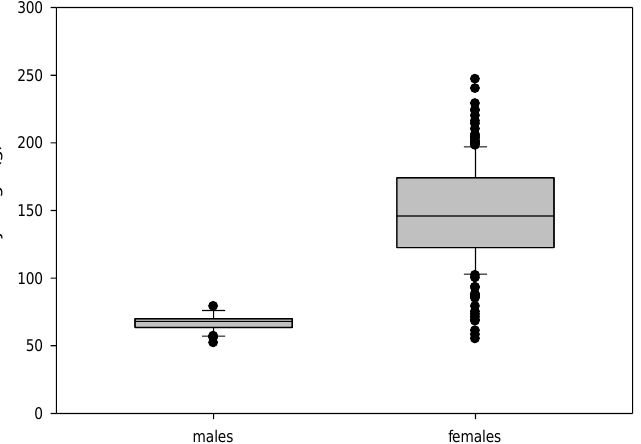
Figure 2. Body weight distribution in adult males ( n = 40) and females ( n = 198). Xenopus laevis (α < 0.001).